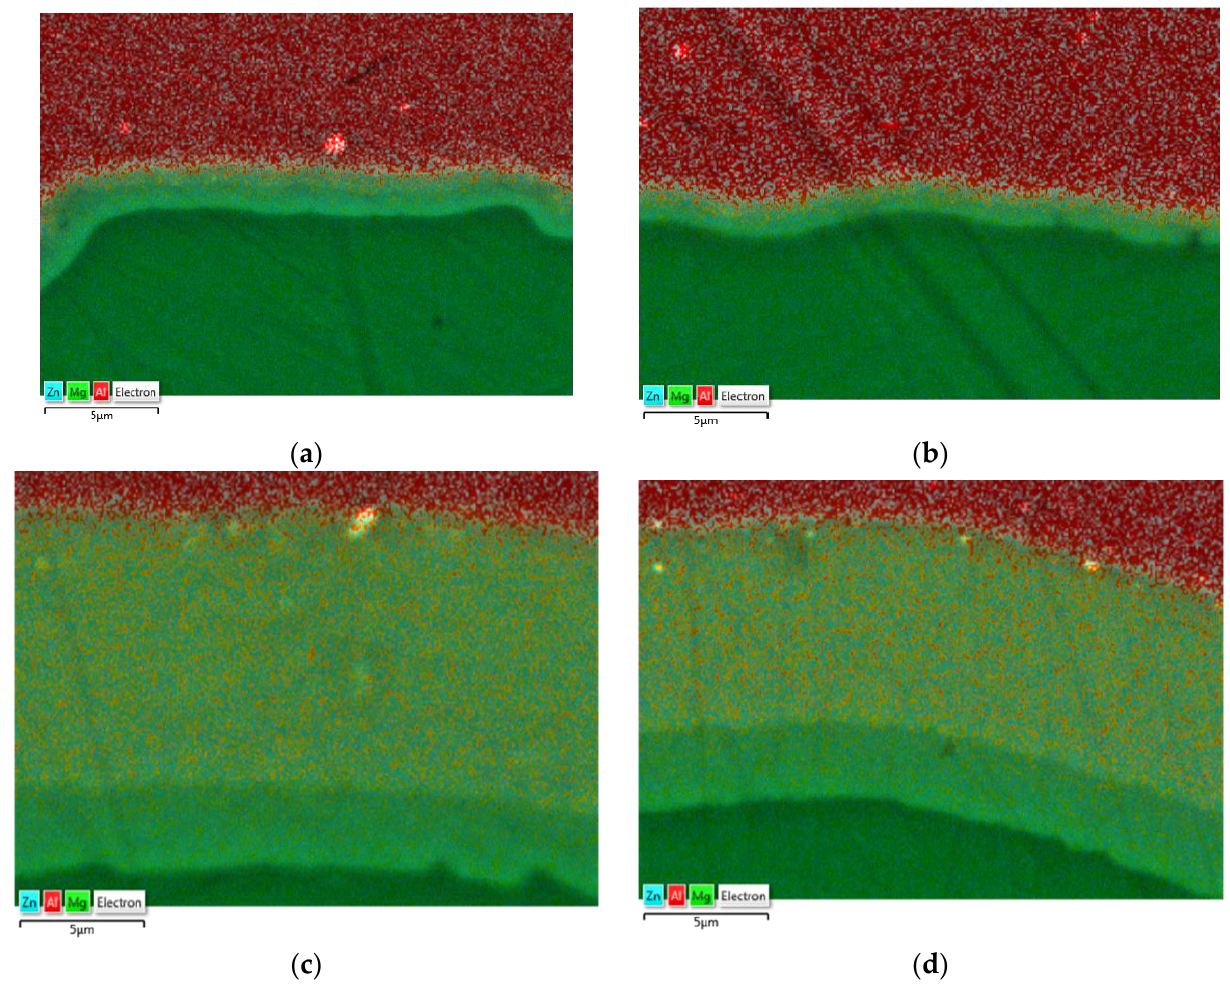
Figure 10. The EDS analysis of the joint zone: classic passes (variant I), temperature of 300 °C ( a ); modified passes (variant II), temperature of 300 °C ( b ); classic passes (variant I), temperature of 400 °C ( c ); modified passes (variant II), temperature of 400 °C ( d ).